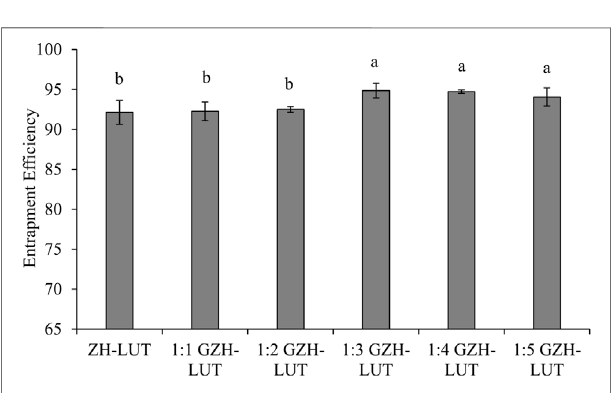
FIGURE 2 | Encapsulation ef fi ciency of ZH-LUT and GZH-LUT.